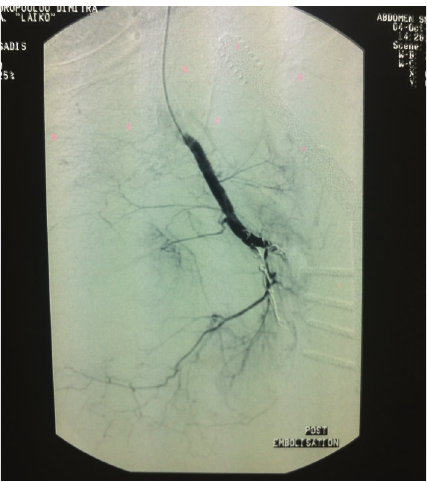
Figure 3: Successful coil embolisation of the two feeding arteries. No extravasation of the contrast agent is